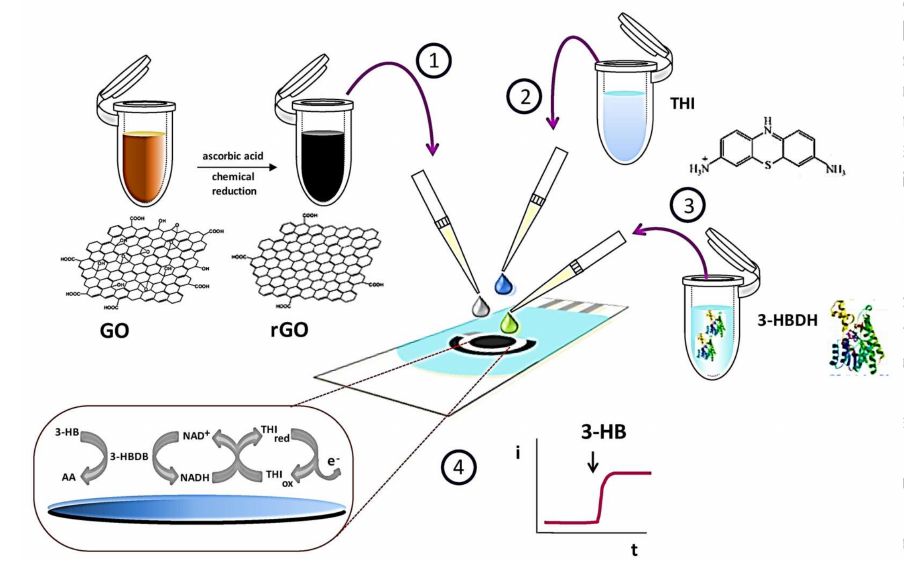
Figure 5. Scheme of the steps involved in the preparation and functioning of the 3-hydroxybutyrate dehydrogenase (3-HBDH)/thionine (THI)/reduced graphene oxide (rGO)/screen-printed carbon electrode (SPCE) biosensor. (Reproduced from Ref. [37], an open-access article distributed under the terms and conditions of the Creative Commons Attribution (CC BY) license (http://creativecommons.